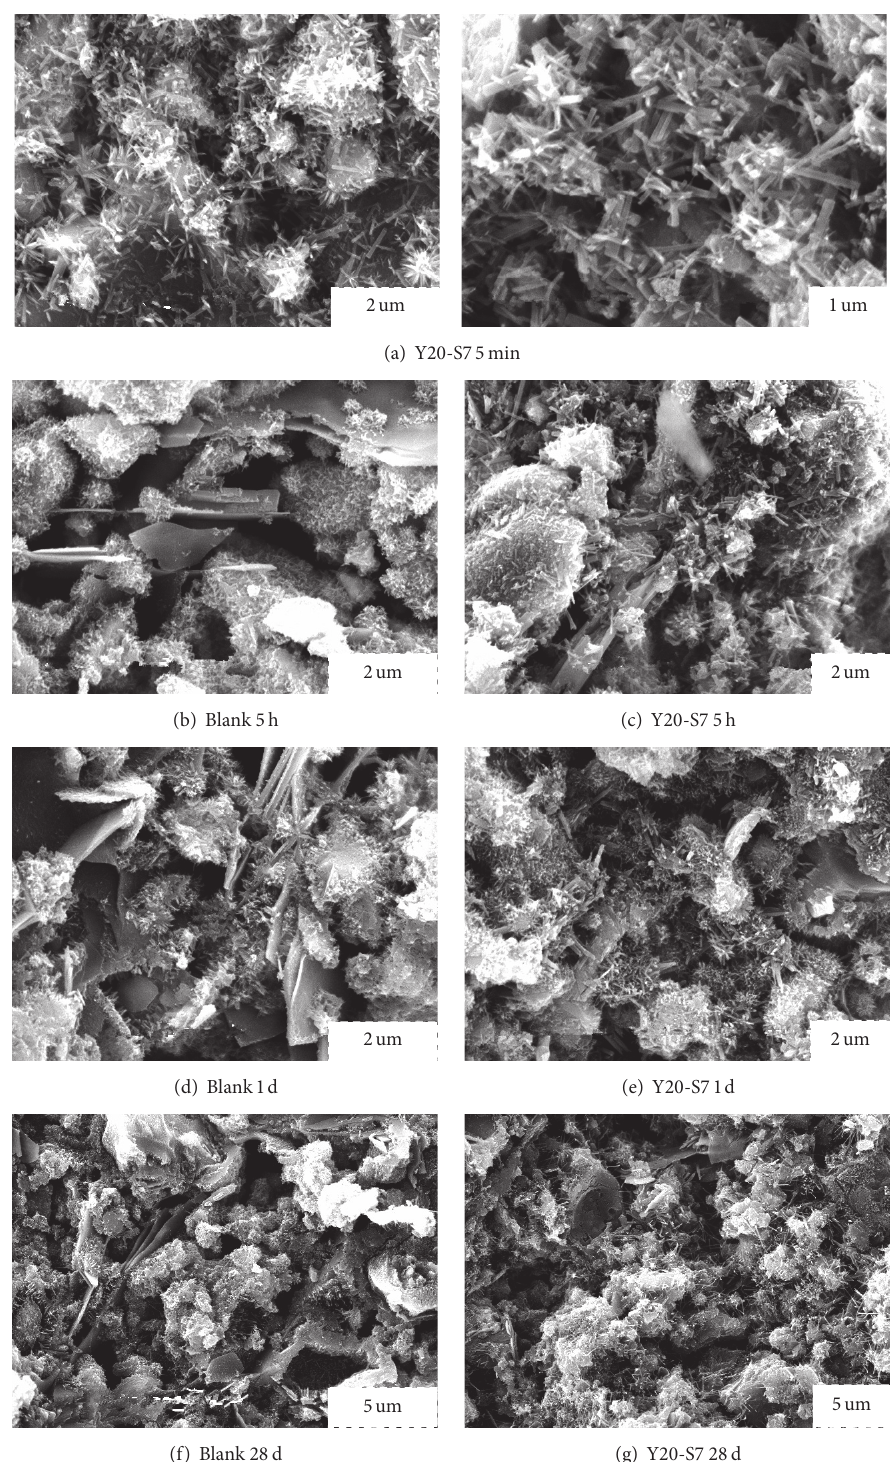
Figure 6: Scanning electron microscope (SEM) photographs of hydrated cement